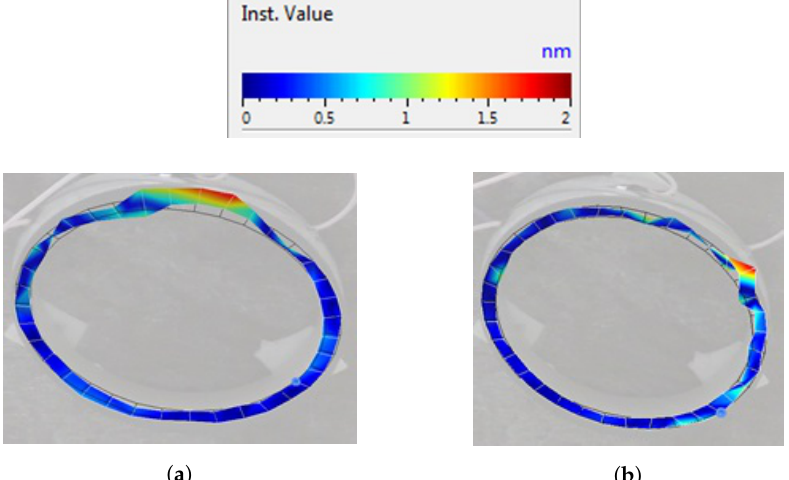
Figure 14. Deformation modes of the end side of piezoelectric cylinder, when an electric signal of the voltage amplitude of 5 V and a driving frequency of 93.6 kHz are applied into the triangle-shaped electrode: ( a ) the driving voltage is connected to the triangle-shaped electrode with the tip directed to the scanned surface; ( b ) the driving voltage is connected to the triangle-shaped electrode with the tip directed backwards to the scanned surface.